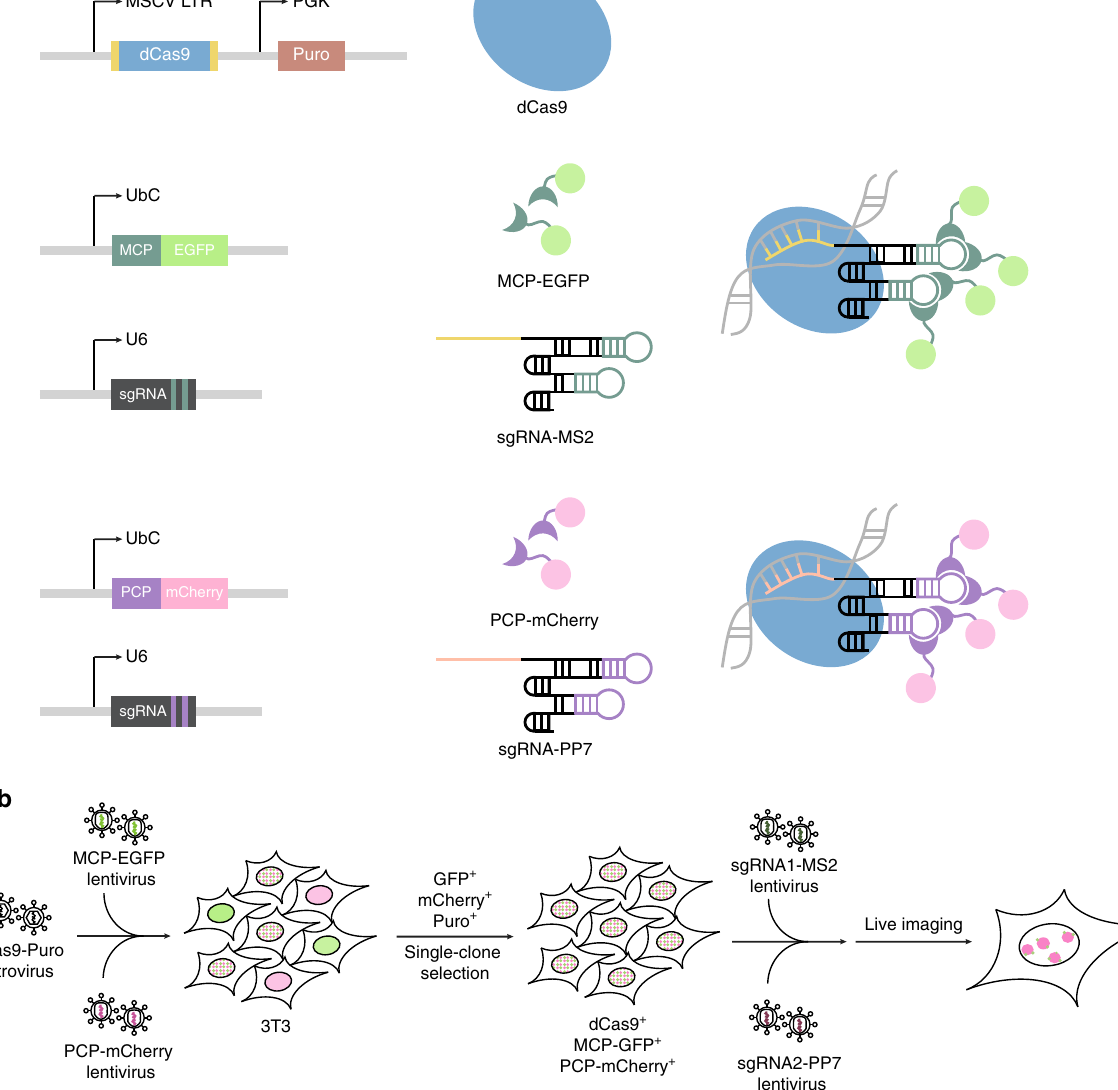
Figure 1 | Components of the dual-colour live imaging system. ( a ) A dCas9 protein surrounded by two nuclear localization signals (in yellow) was expressed from a retroviral plasmid containing a puromycin resistance gene. sgRNAs were expressed from a U6 promoter and these could either be transfected or delivered via lentivirus. The sgRNA scaffolds contain double PP7 or MS2 stem loops. The proteins MCP and PCP fused to EGFP or mCherry, respectively, were expressed from lentiviral plasmids. dCas9 allows binding of sgRNAs to their target DNAs and sgRNAs containing MS2 or PP7 stem loops can each recruit four molecules of MCP-EGFP or PCP-mCherry, respectively. ( b ) Workflow for dual-colour live imaging. To test the system, 3T3 fibroblasts were co-infected by the dCas9 retrovirus and with the MCP-EGFP and PCP-mCherry lentiviruses, followed by puromycin selection and FACS for EGFP and mCherry double positive cells. Single clones based on low background expression of fluorescent proteins and high efficiency of labelling were selected. Optimal clonal cells can then be transduced or transfected with plasmids carrying sgRNAs for subsequent live